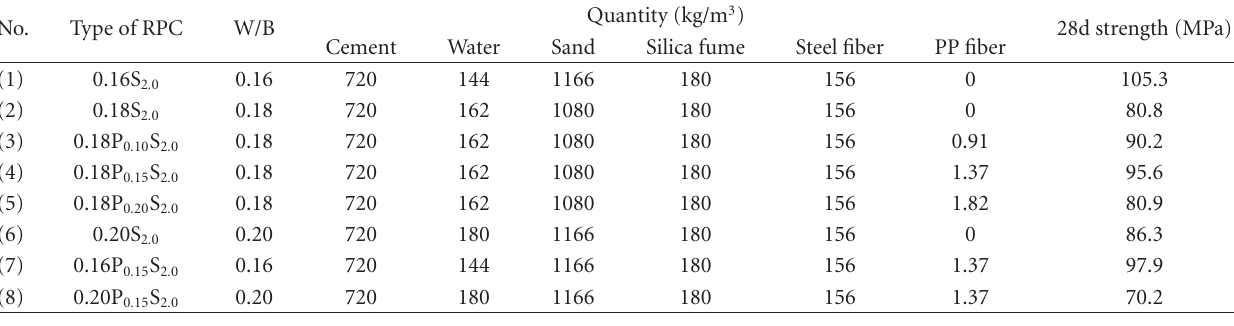
Table 1: Mix proportions and compressive strength of RPC tested.